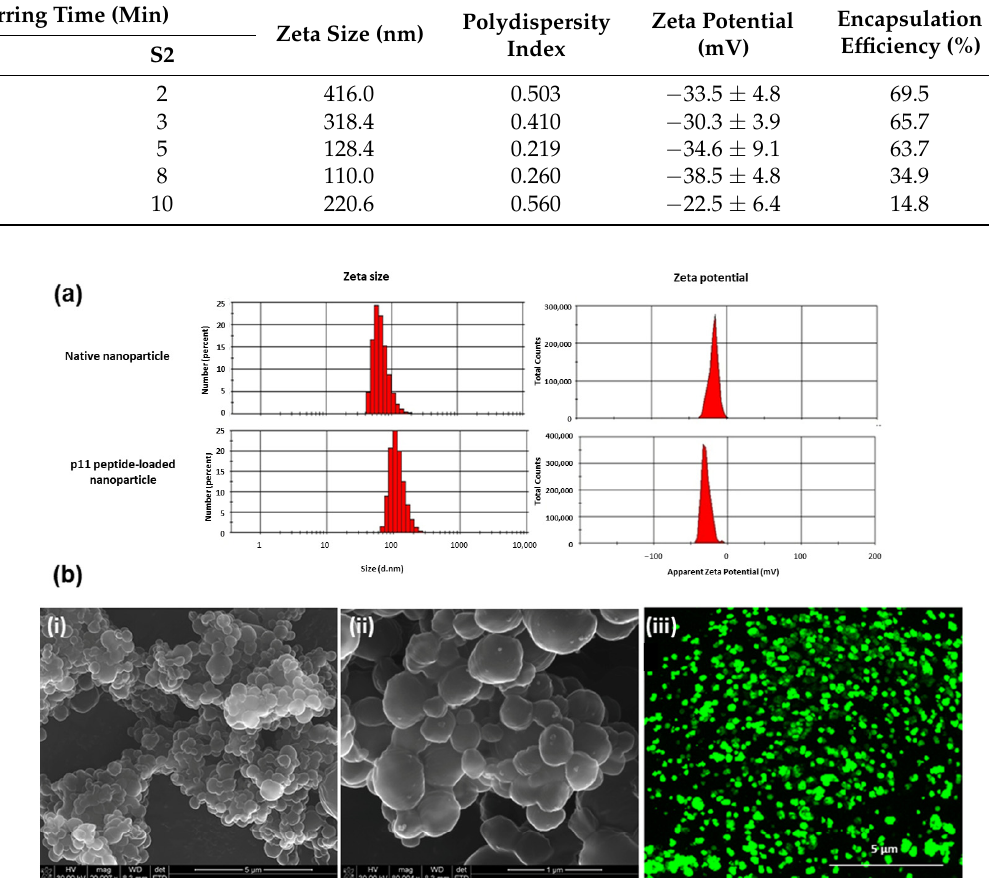
Table 2. Physicochemical characterisation of p11 peptide-loaded PLGA (poly(lactic- co -glycolic acid)) nanoparticles.